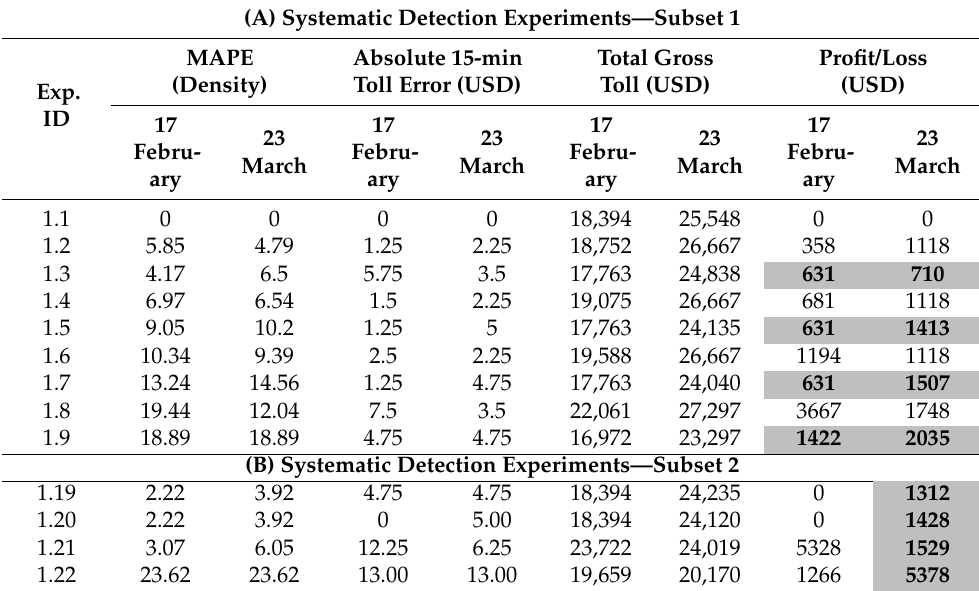
Table 4. Results of systematic detection error scenario for the Southbound